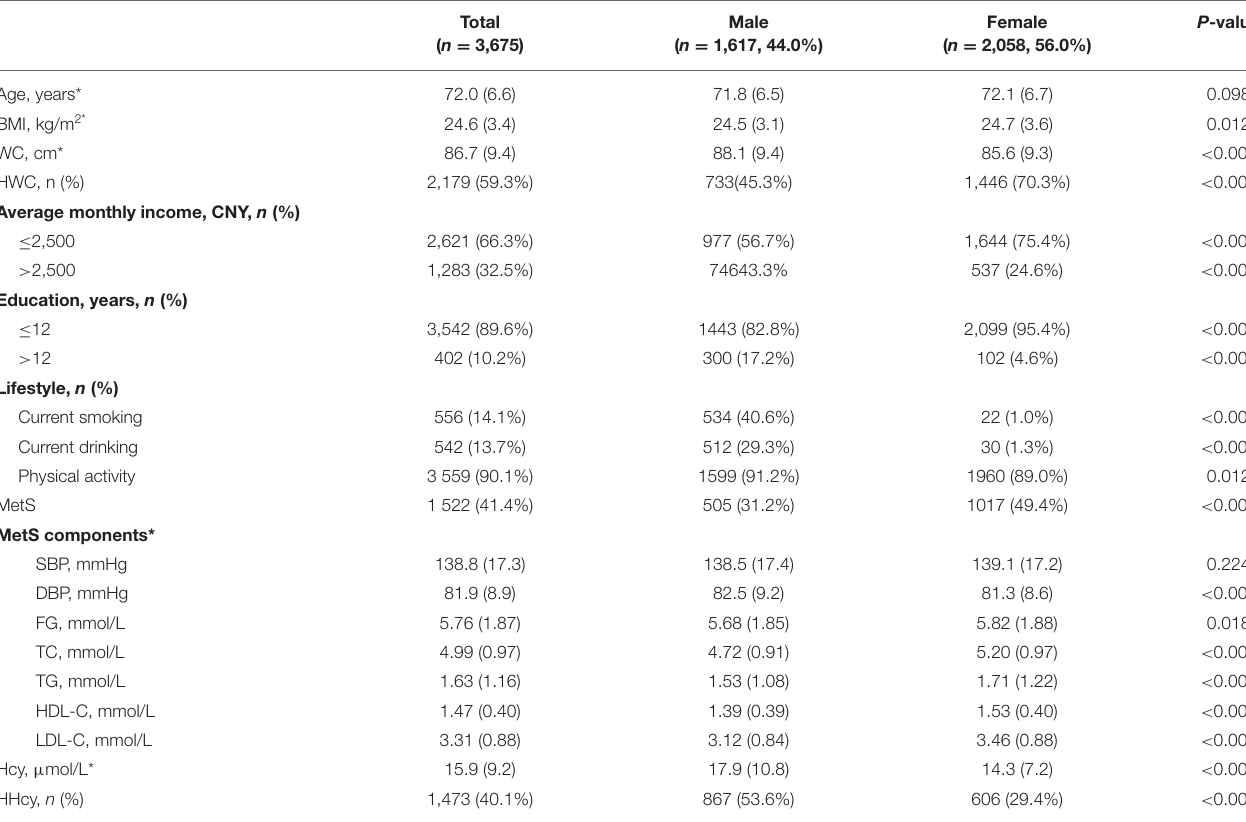
TABLE 1 | Baseline characteristics of study